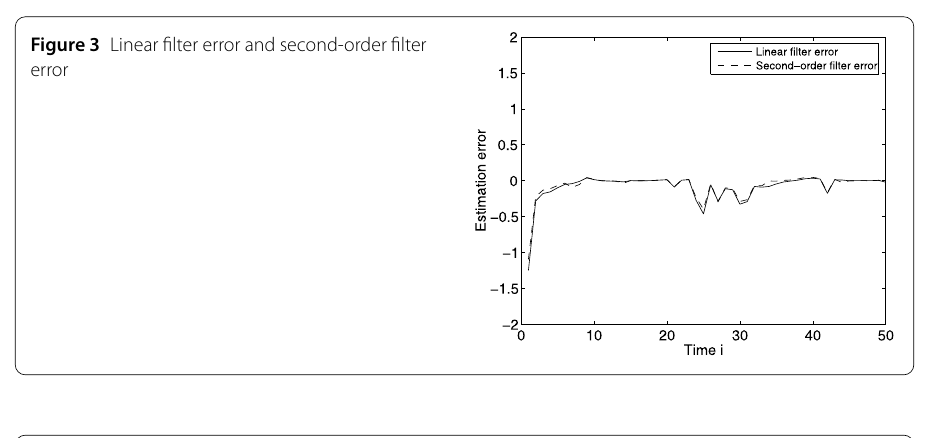
Figure 3 Linear filter error and second-order filter error